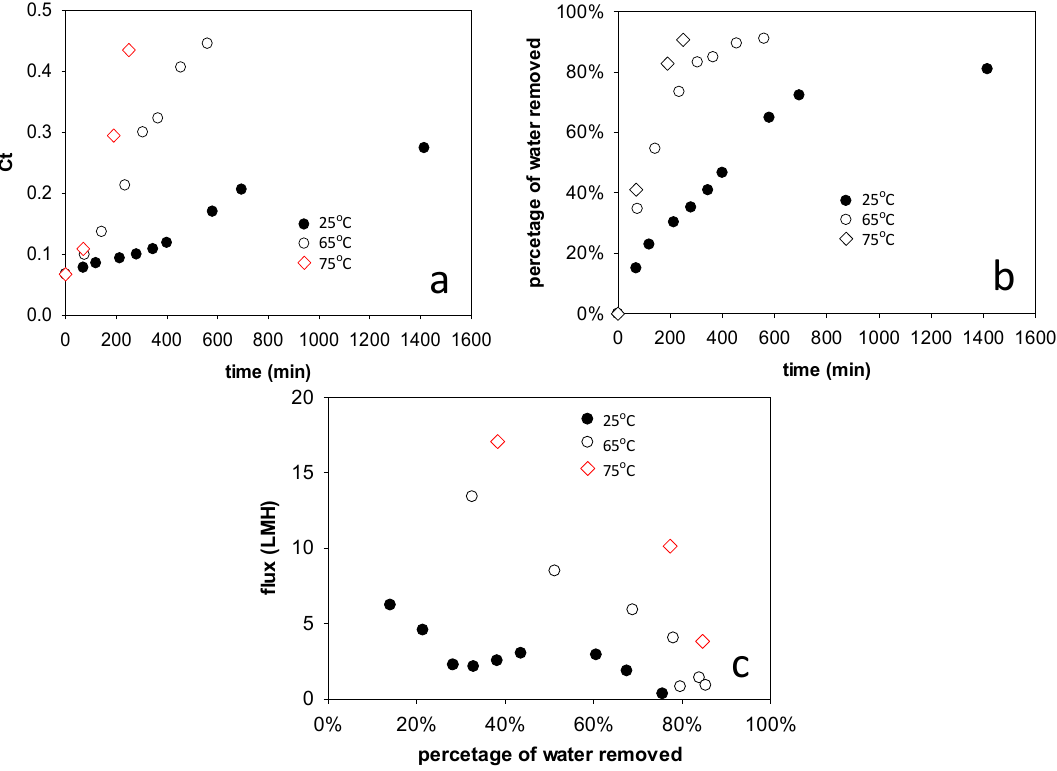
Figure 6. ( a ) Solid concentration of stick water over time at different temperatures; ( b ) Percentage of water removed over time at different temperatures; ( c ) Dewatering flux versus percentage of water removed at different temperatures. Starting concentration was 6.7 wt %.